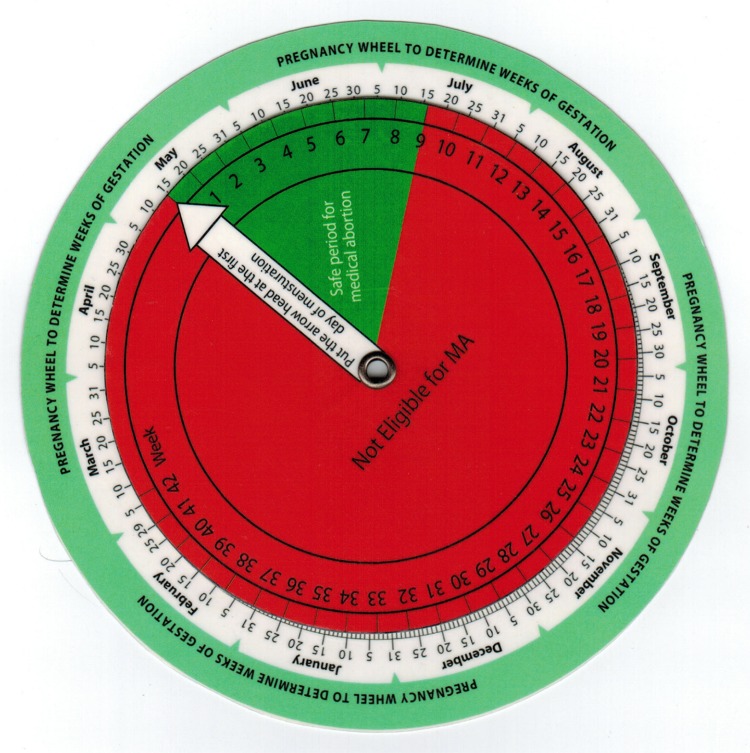
Modified gestational dating wheel.To use the wheel, turn the wheel until the arrow points at the first day of the woman’s reported LMP, then find the current date on the wheel. If the date is in the green zone (here, from May 15 to July 15) the woman is eligible for MA based on the gestational age of the pregnancy (< 63 days). If the date is in the red zone, she is not eligible. (Note: the version used in the study included the Nepali calendar and all instructions written in in Nepali).